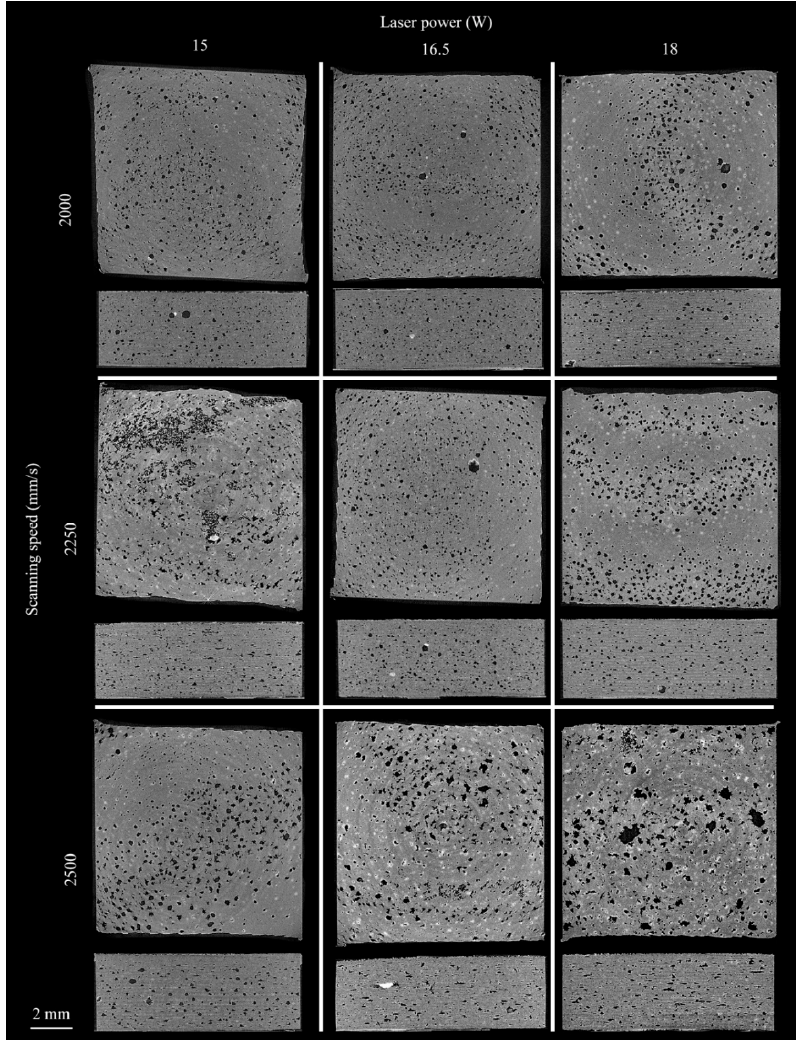
Figure 8. Representative slices from each of the sample batches. The slices display the interlayer connection and the side view of the samples. The sample slices are organized as: top row : 2000 mm/s scanning speed; middle row : 2250 mm/s scanning speed; bottom row : 2500 mm/s scanning speed; left column : 15 W laser power; middle column : 16.5 W laser power; right column : 18 W laser power.